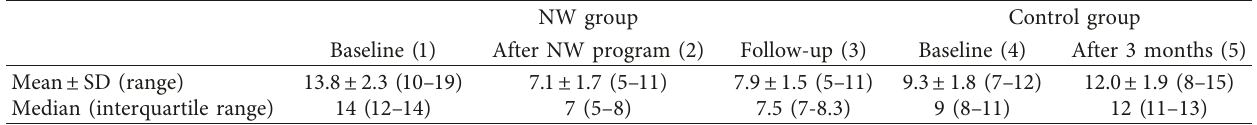
Figure 1: Freezing of Gait Questionnaire scores in the NW and control groups at different timepoints. In all boxplots, the median is presented together with interquartile range; whiskers represent the 5th and 95th centile. Table 2: Freezing of Gait Questionnaire.